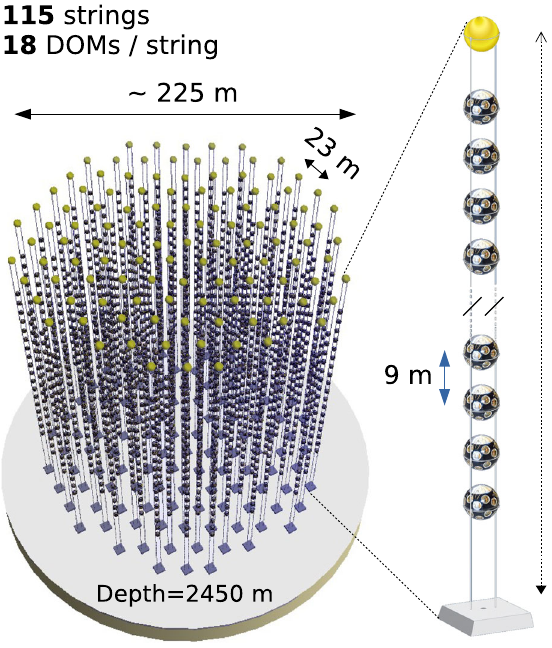
Fig. 1 Schematic view of the KM3NeT/ORCA detector